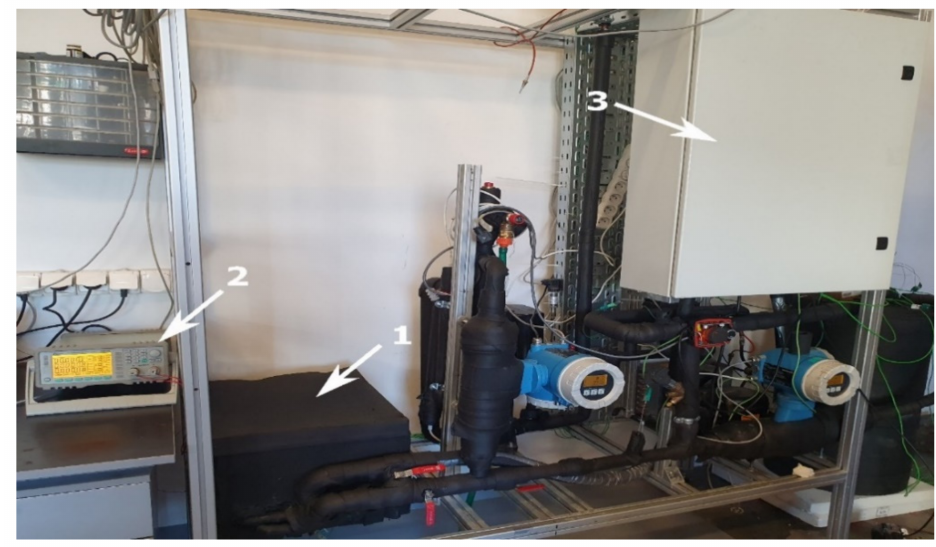
Figure 7. Photo of the experimental stand: 1—calorimeter, 2—electric heater power supply, 3—control and measurement